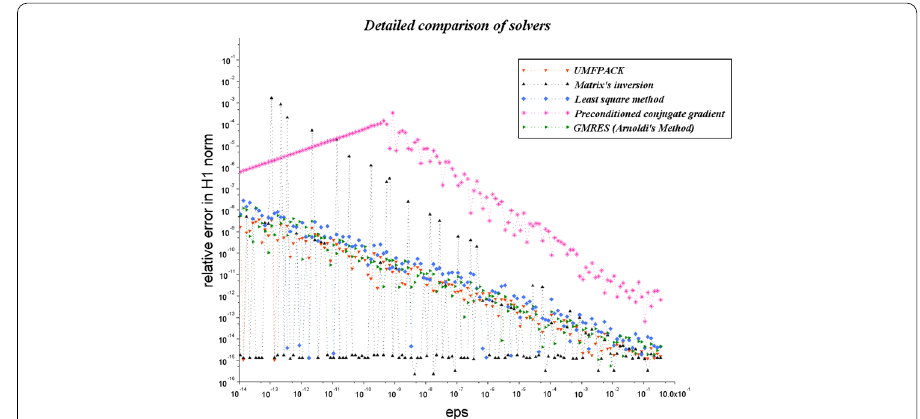
Fig. 12 Overall error analysis of a wide range of solvers for the 1D case. Only X-FEM’s enrichment without pre-conditioner is studied here. The whole trend suggests a global increase of the sensitivity of solvers (with respect to epsilon), when the “epsilon” parameter goes to zero